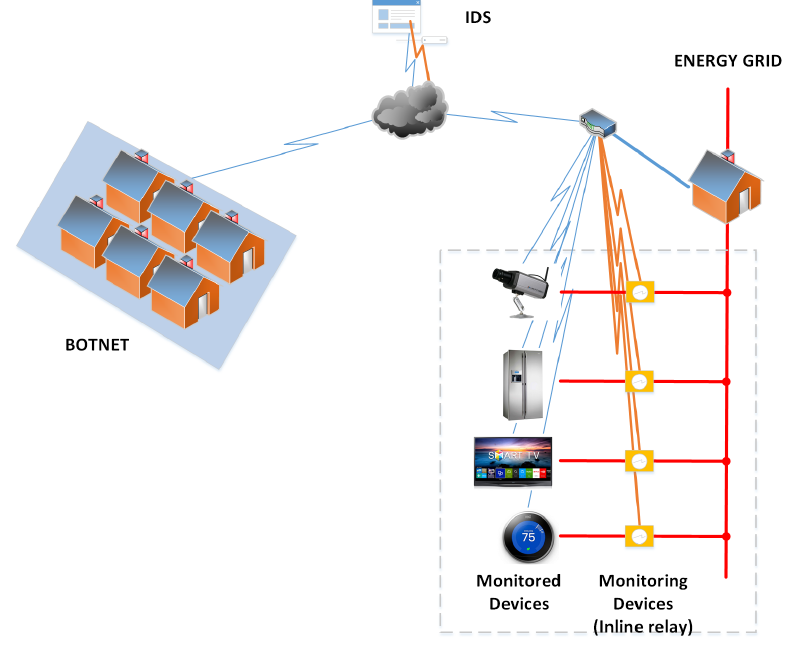
Figure 1. Topology of the monitoring devices in a